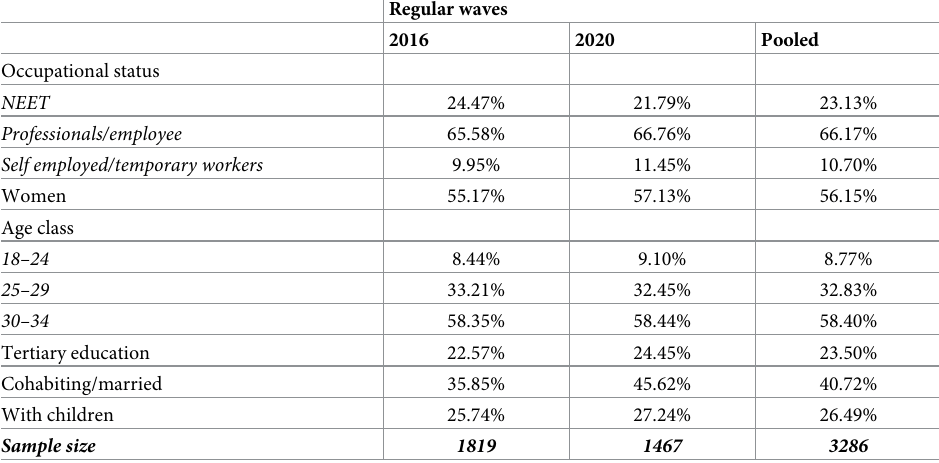
Table 3. Distribution of the main covariates and control variables for the regular waves (2016 and 2020); sepa- rated and pooled